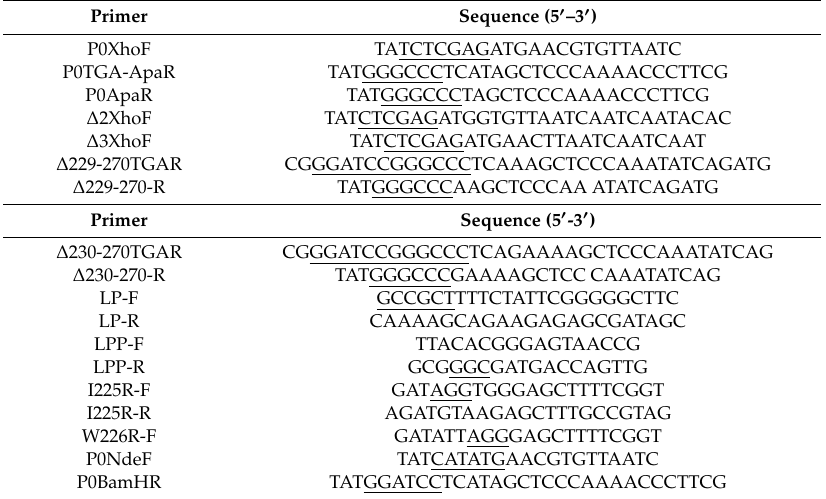
Table 1. Primer sequences used for polymerase chain